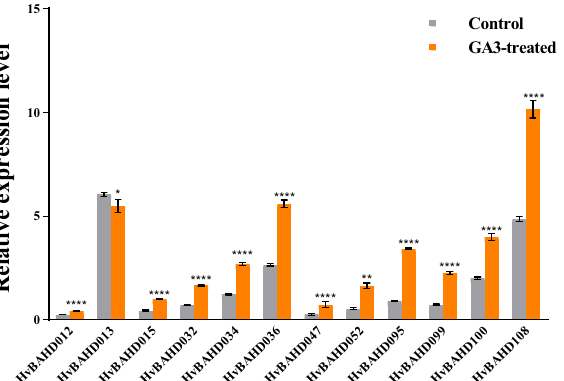
Figure 9. Relative expression of HvBAHD genes after 5 days of GA3 treatment in barley seedlings. Gray was used as the control group and orange was used as the GA3 treatment group. (P < 0.0001, ****, P < 0.001,